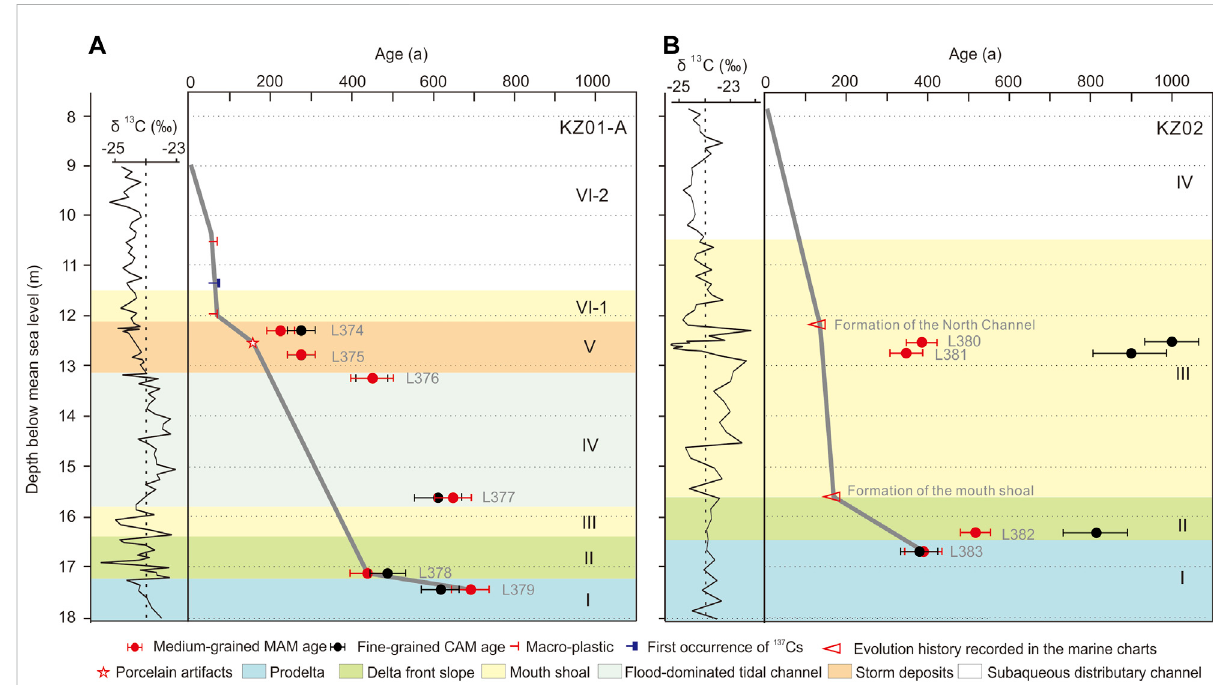
FIGURE 5 Comparison of various chronologies obtained in cores KZ01-A (A) and KZ02 (B) . Core depths are calibrated into depths below the mean sea level. The δ 13 C curves and evolution history of North Channel are from Niu et al. (2021). Unit numbers are as in Figure 3. The solid line indicates the best estimated age-depth